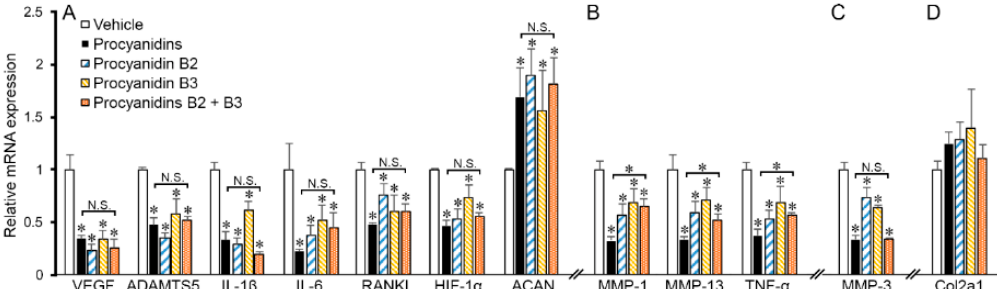
Figure 6. The effects of procyanidin B2 and B3 on expression of VEGF and genes that may be regulated by VEGF and involved in OA pathogenesis compared to those of procyanidins in primary human OA chondrocytes in the presence of human recombinant VEGF. mRNA expression of ( A ) VEGF, ADAMTS5, IL-1 β , IL-6, RANKL, HIF-1 α and aggrecan ( ACAN ); ( B ) MMP-1, MMP-13, TNF- α ; ( C ) MMP-3 ; and ( D ) Col2a1 in human primary OA chondrocytes treated with procyanidins (50 µg/mL), procyanidin B2 (1 µg/mL), procyanidin B3 (1.25 µg/mL) and procyanidins B2 + B3 (1 and 1.25 µg/mL respectively) in the presence of human recombinant VEGF (10 ng/mL). (* p < 0.05 vs. vehicle control or indicated comparison, one-way ANOVA with Tukey post-hoc test; N.S.: not significant, p > 0.05; n = 3/group).